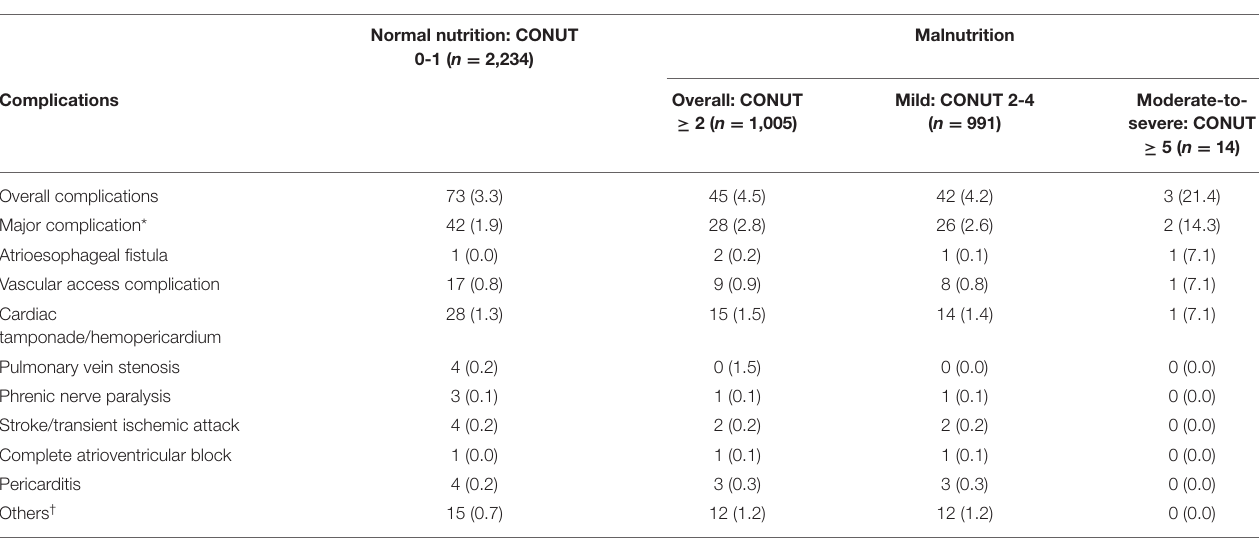
TABLE 3 | Complications after the de novo catheter ablation of atrial fibrillation.